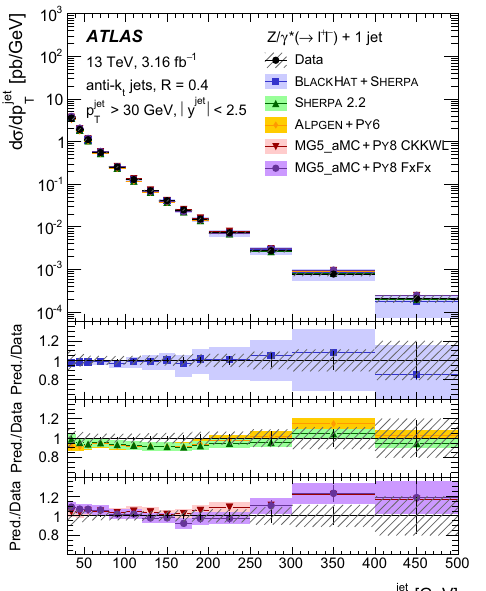
Fig. 5 Measured cross section as a function of the leading jet p T for inclusive Z + ≥ 1 , 2 , 3 , 4 jet events ( left ) and absolute value of the leading jet rapidity for inclusive Z + ≥ 1 jet events ( right ). The data arecomparedtothepredictionsfrom Z + ≥ 1 jet N jetti NNLO, Black- Hat+Sherpa , Sherpa 2.2 , Alpgen+Py6 , MG5_aMC+ Py8 CKKWL, and MG5_aMC+ Py8 FxFx. The error bars correspond to the statisti- cal uncertainty, and the hatched bands to the data statistical and sys-